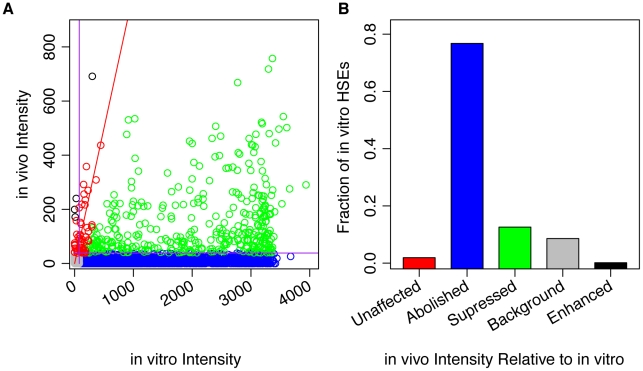
In vitro and in vivo binding of HSF to genomic HSEs do not correlate.A) A scatter plot comparing the observed in vivo HSF binding intensity and in vitro binding intensity for each isolated HSE indicates that the vast majority of in vivo binding is suppressed (green) or abolished (blue), if we assume that the top seven most DNase I hypersensitive isolated HSE clusters provide the best estimates for sites that are minimally influenced by chromatin. After scaling, red points have similar in vivo and in vitro intensity, black points may be enhanced in vivo, while green and blue points are suppressed and abolished, respectively. B) The points from panel A were categorized, and the resulting bar chart shows the relative frequencies of each category.